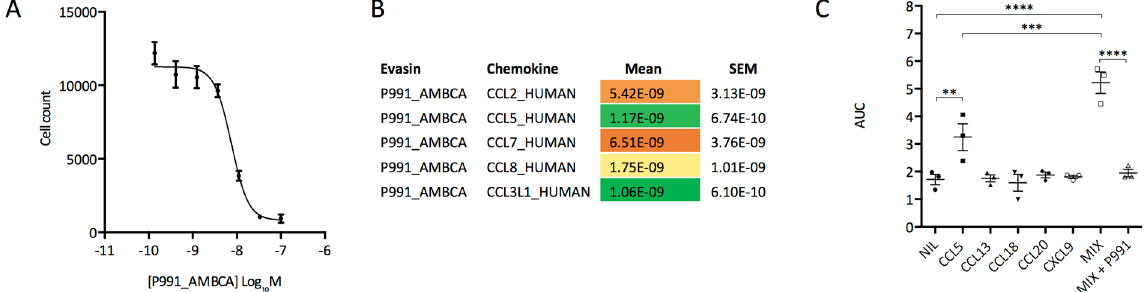
Figure 7. Functional neutralization of chemokine activity. ( A ) Neutralization of CCL2 induced THP-1 cell migration by P991_AMBCA. Y-axis shows cell count of THP-1 cells migrating through to the bottom chamber in response to EC 80 dose of CCL2. Data (3 technical replicates) are shown as mean ± s.e.m. X-axis shows P991_AMBCA concentration (Log 10 Molar). ( B ) Summary of P991_AMBCA IC 50 data (moles/litre, mean, s.e.m. of 3 biological replicates analyzed as above) for chemokines that induce THP-1 cell migration. Lower IC 50 is indicated as shades of green, medium as yellow, and high as shades of orange. ( C ) Neutralization of a complex chemokine mixture by P991_AMBCA. Y-axis shows AUC (area under progress curve) in response to indicated treatments shown on the x-axis. NIL indicates baseline migration without any chemokine. Results (mean ± s.e.m., and individual data points) of 3 independent biological replicate experiments are shown, and were analyzed with one-way ANOVA with Sidak’s multiple comparisons test and P values adjusted for multiple comparisons. * Indicates P < 0.05, ** Indicates P < 0.01, *** P < 0.001, **** P <